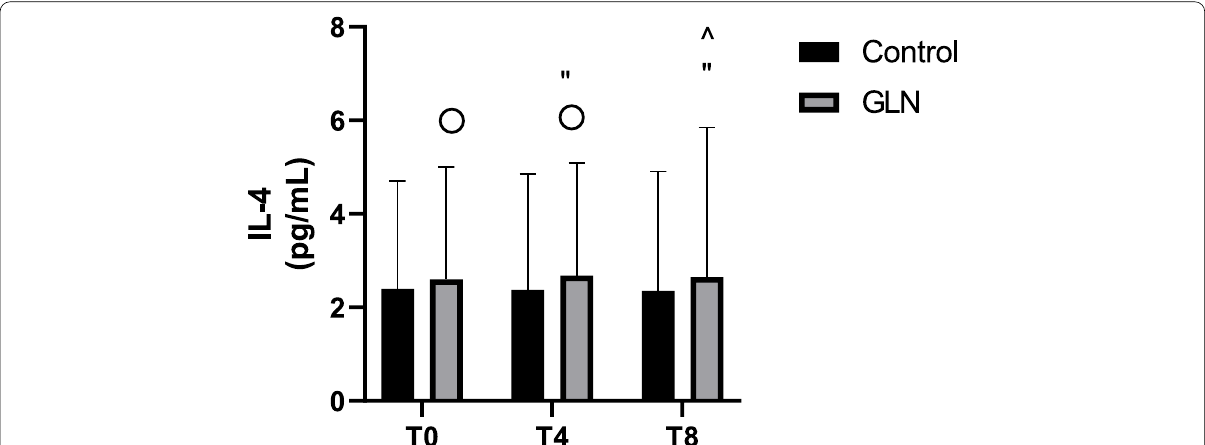
Fig. 6 IL-4 levels in control and glutamine (GLN) groups. Data are presented as mean the GLN